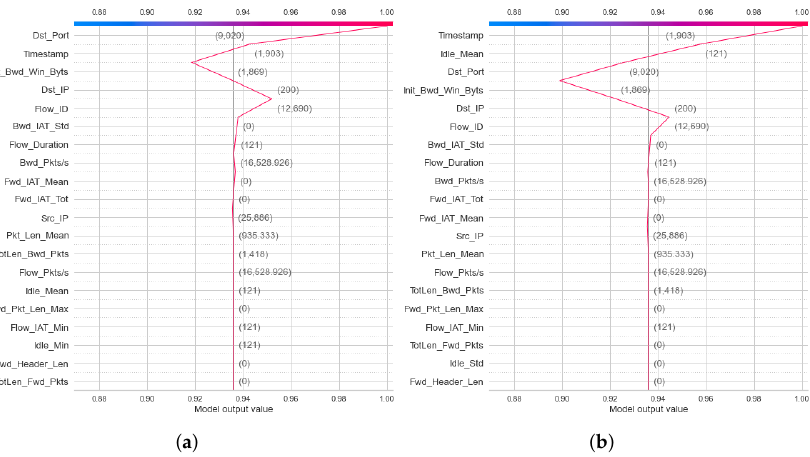
Figure 13. Decision plot results of local explanation for IoTID20 dataset in two Label output values: